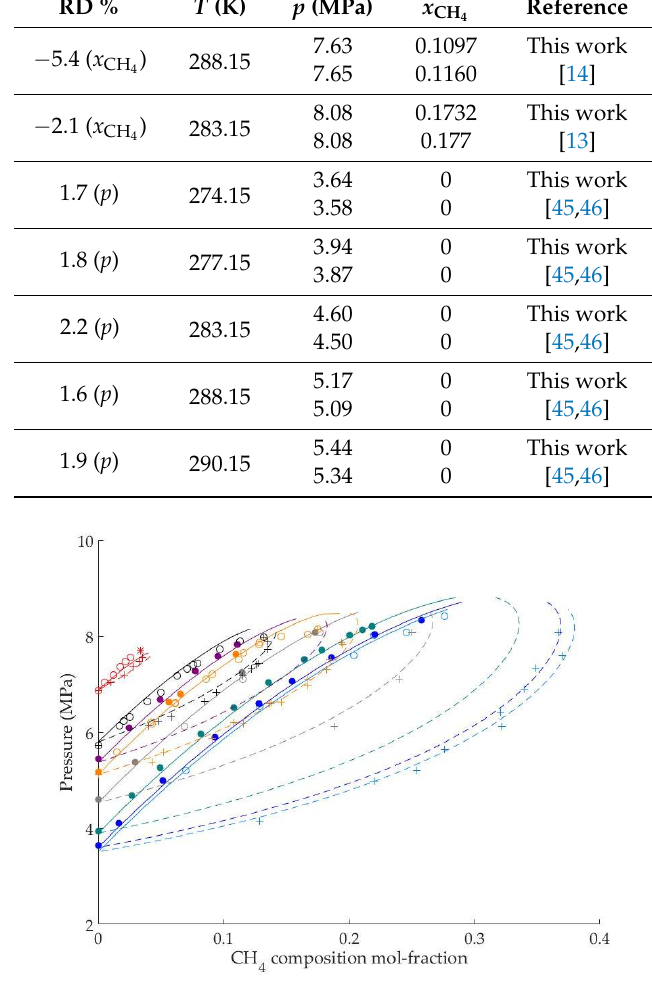
Table 3. Relative deviation (RD) of solubility data (mole fractions) and vapor pressures (of pure CO 2 with x CH4 = 0) between this work and literature values.